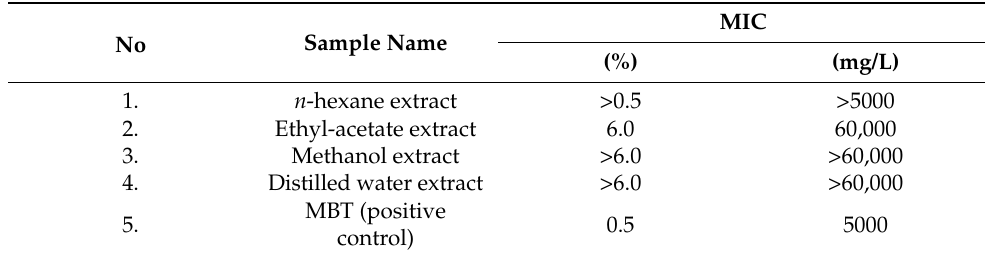
Table 6. Minimum inhibitory concentration (MIC) of all fungus-comb extracts and MBT against A. foetidus